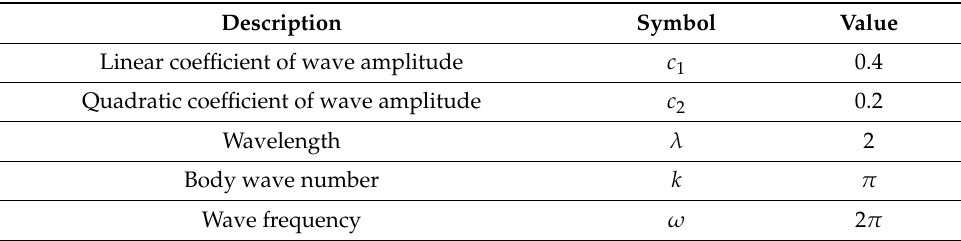
Figure 3. Reference coordinate system with the origin in the tip of the fish snout and the x axis Table 2. Selected value of the parameters used for modelling the traveling wave. directed along the midline of fish body when it is in straight configuration, positive towards the tail. Table 2. Selected value of the parameters used for modelling the traveling